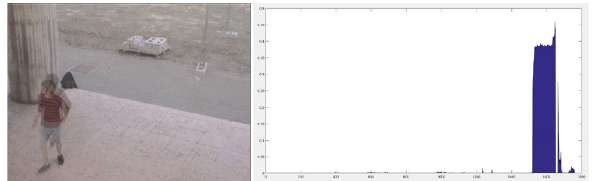
Fig. 3 (left) A scene where a person leaves a bag and then another person comes and takes it. (right) The graph of compari- son between the frames and the corresponding temporary back- ground model. X axis is the frame number, Y axis is the percentage of change between the frames and the temporary background model. The graph indicates critical background changes near the frame 1500 and 1700, the moments of bag deposit and retrieval. VISOR Dataset